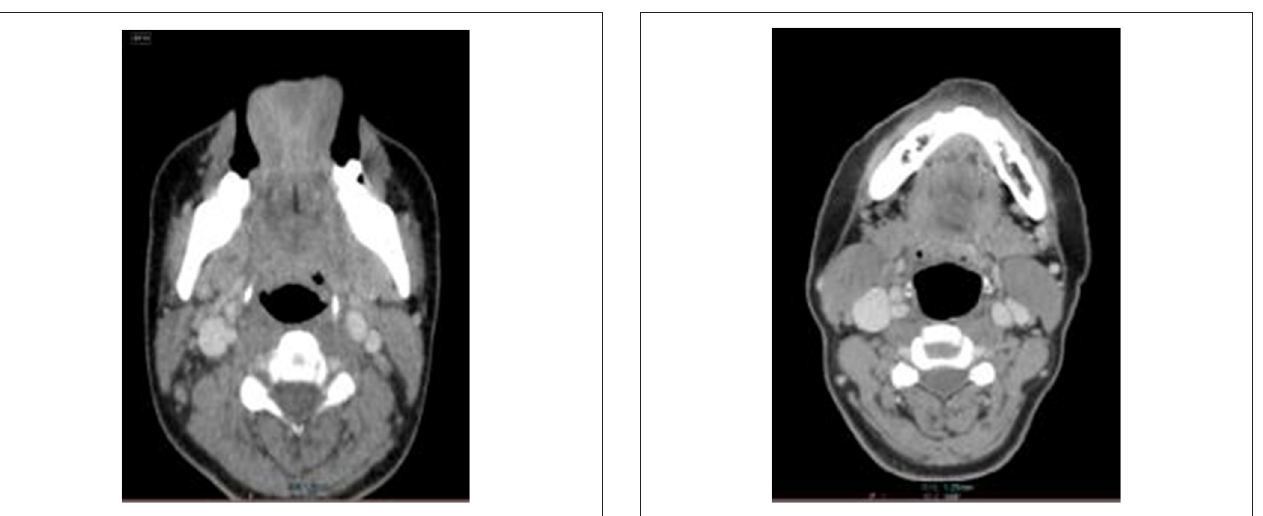
FIGURE 2 | The score of 1 point,with significantly narrowed bilateral epiglottic fossas and partially closed.